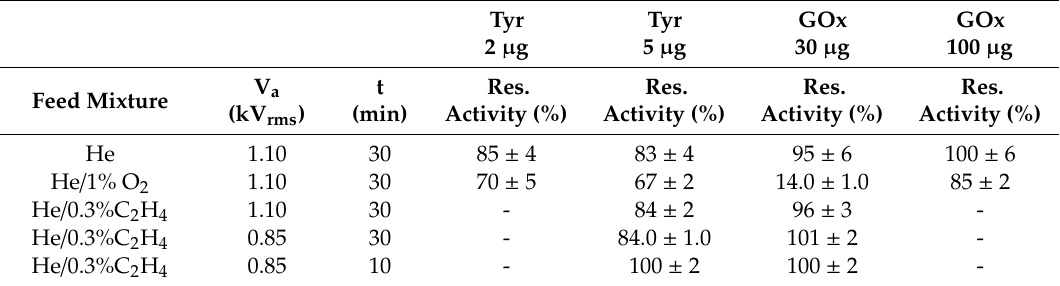
Table 4. Tyr and GOx residual activity after selected plasma processes (complete plasma processing conditions are reported in Table 1). GOx data are taken from Ref. [35].